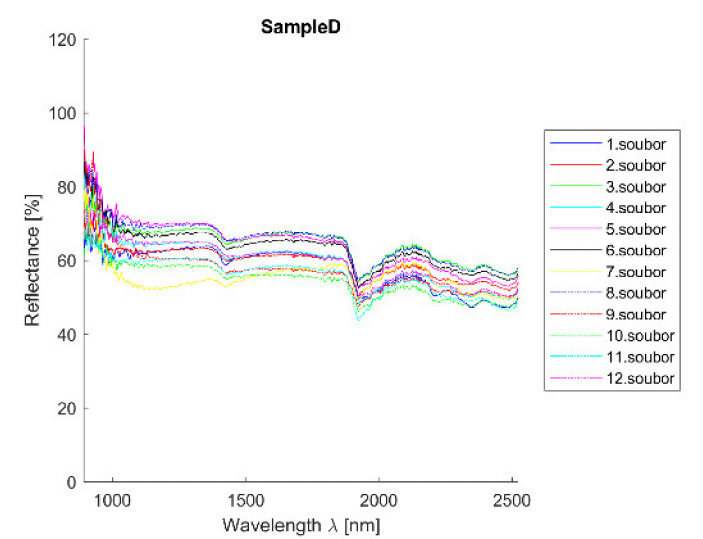
Figure 18. Sample D—DinoLite microscope image, magnification 200 × . Acquired reflectance spectroscopy data were processed and analyzed using a MAT- LAB script. Analysis results are mentioned below, and Figures 19 and 20 show spectral graphs of the sample.